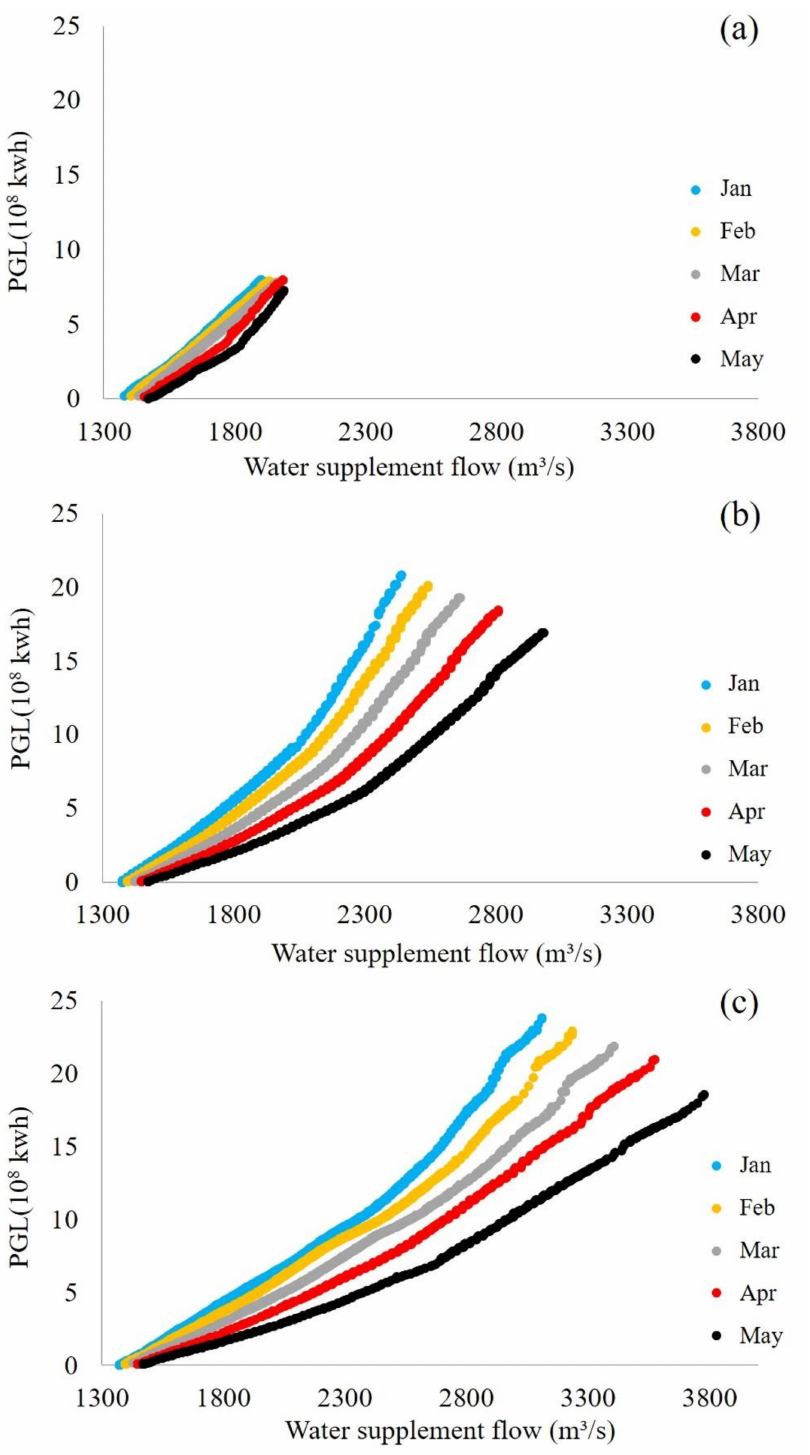
Figure 13. Results of PGL of the three typical years, ( a ) Dry year, P = 75%; ( b ) normal year, P = 50%; and ( c ) wet year, P =